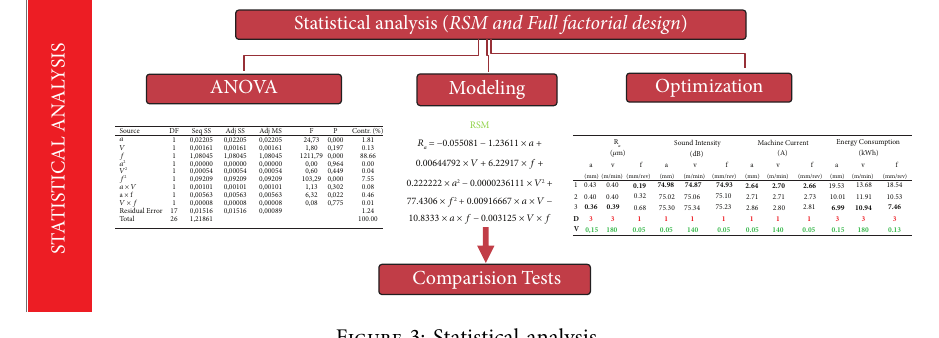
Figure 3: Statistical